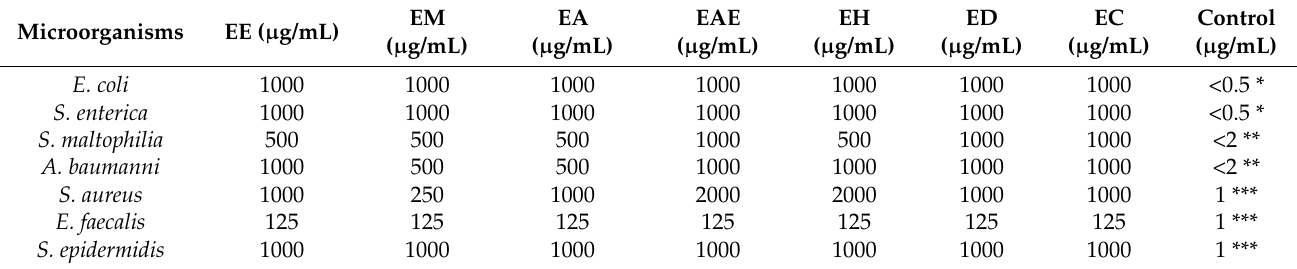
Table 2. Minimum inhibitory concentration (MIC) in µg/mL, obtained for the EE, EM, EA, EAE, EH, ED and EC leaf extracts from M. linifera in E. coli, S. enterica, S. maltophilia, A. baumanni, S. aureus, E. faecalis and S. epidermidis strains. Microorganisms